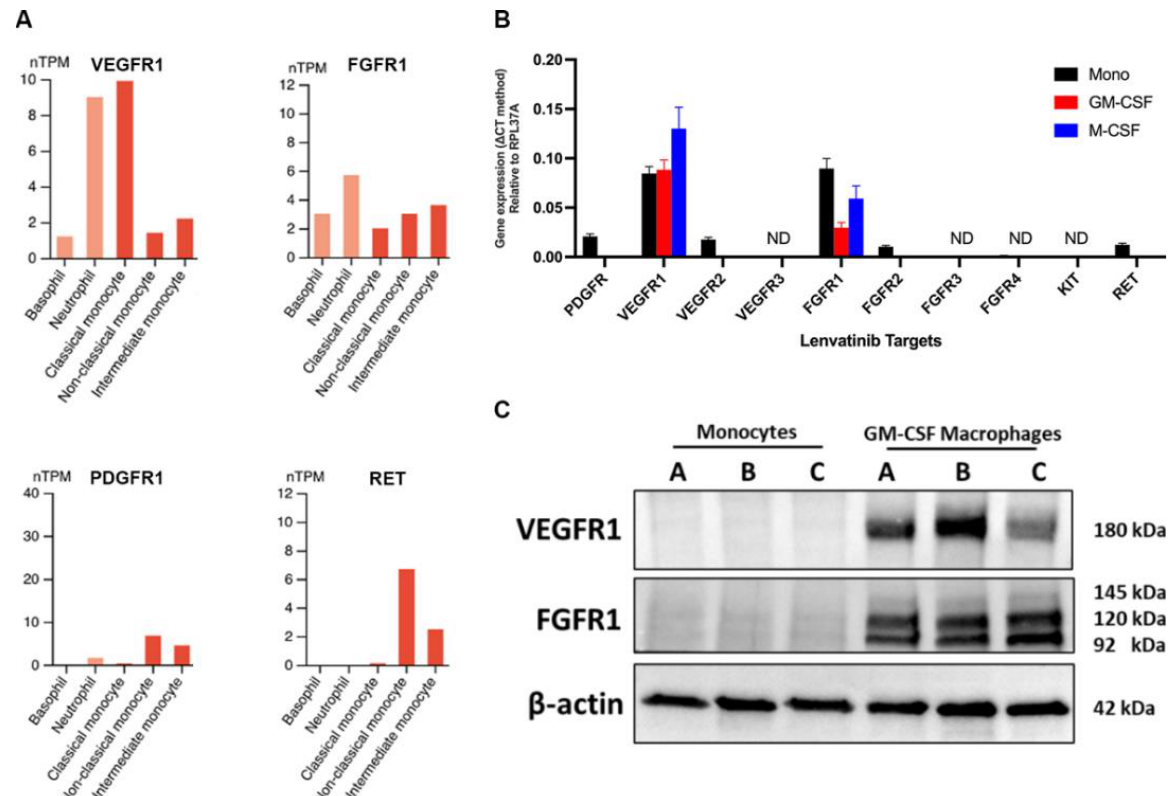
Figure 5. The expression of Lenvatinib-targeted RTKs on monocytes. ( A ) Normalized transcript expression levels of 4 detectable Lenvatinib-targeted RTKs (VEGFR1, FGFR1, PDGFR, RET) from the transcriptome signatures are visualized for different peripheral myeloid cell types from Monaco et al. The panels are screenshots from the Human Protein Atlas resource. ( B ) Quantified Lenvatinib- targeted RTKs mRNA expression by RT-qPCR. Transcript copy number was normalized to cellular control (RPL37A). n = 6. ( C ) Levels of VEGFR1 and FGFR1 in the cell lysate from buffy coat monocytes and GM-CSF polarized macrophages were analyzed by Western blot, and β -actin was used as the loading control. Three isoforms of FGFR1 were detected with molecular weights of 92, 120, and 145 kDa. n = 3. ND, not determined; nTPM, normalized transcripts per million.